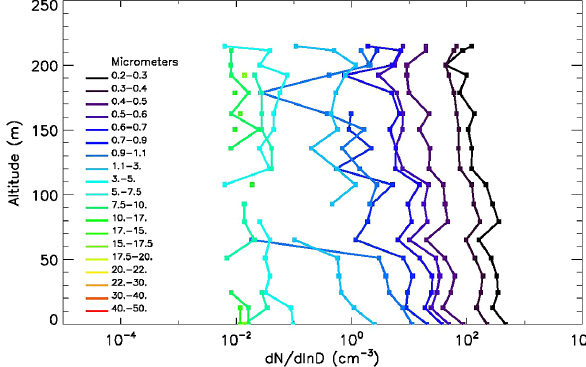
Figure 5. Evolution of the concentrations for the 19 size classes of LOAC, during a flight under a tethered balloon in Vienna (Austria) on 11 April 2013 at 11:00UT; the uncertainty (at 1 σ ) is of about ± 20% for concentrations higher than 10 − 1 cm − 3 up to ± 60% for concentrations lower than 10 − 2 cm − 3